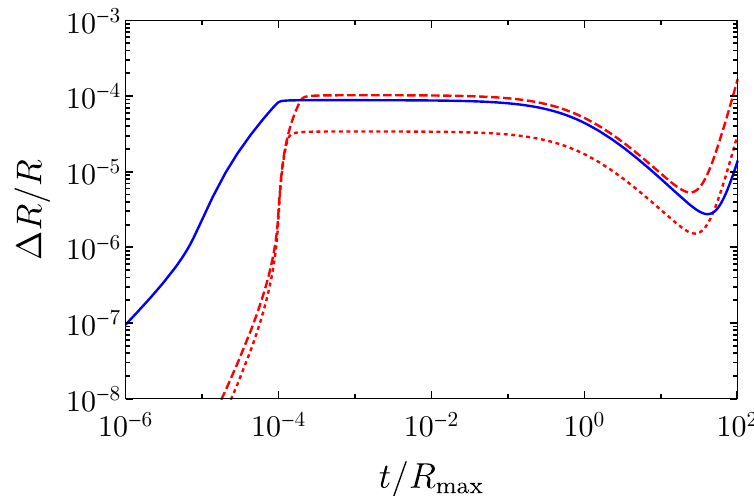
Figure 7 . We show how two bubbles with the same initial size can end up with much larger fractional di(cid:11)erences in bubble radius ((cid:1) R=R ). The blue solid line shows how di(cid:11)erent in size two bubbles can get with di(cid:11)erent initial velocities. The two bubbles are assumed to start at 10% and 90% of the initial shock wave velocity. The red lines show how di(cid:11)erent in size two bubbles can get with di(cid:11)erent matter densities. The two bubbles are assumed to start in regions where the matter densities di(cid:11)er by 50% (upper red dashed line) and 25% (lower red dotted line),